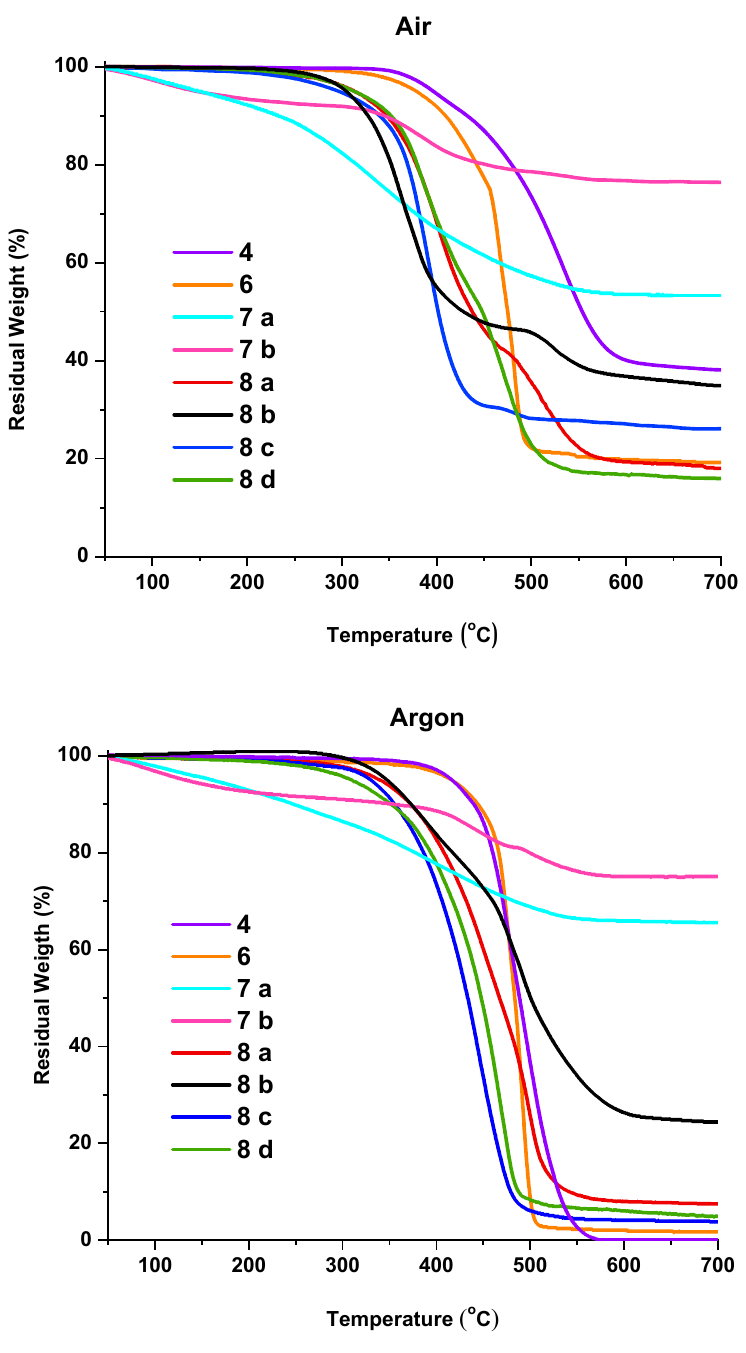
Figure 9. Thermogravimetric analysis (TGA) curves for compounds 4 , 6 , 7 a , b, and 8 a – d in air ( top ) and argon ( bottom ) with a heating rate of 10 °C/min.